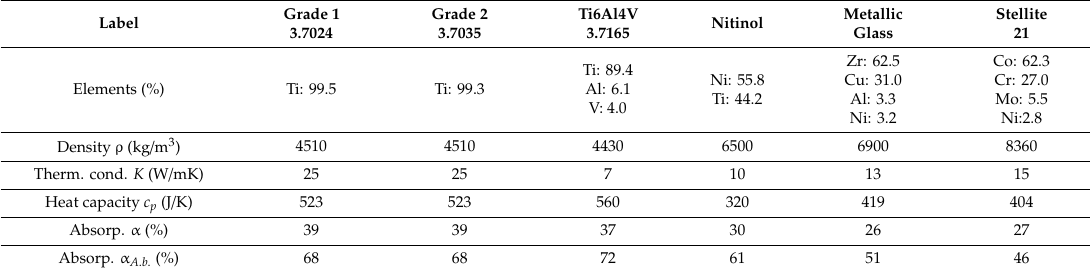
Table 1. Overview of the conducted experiments and their machining